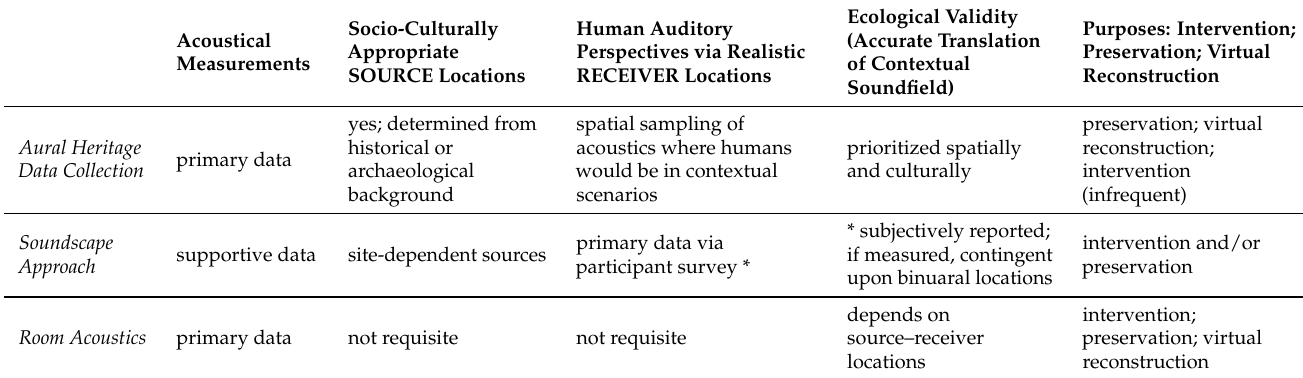
Table 1. Comparison of approaches used in heritage acoustics research: approach (left column) vs. cultural heritage acoustics concerns addressed (across). * Indicates data that may be subjectively reported rather than